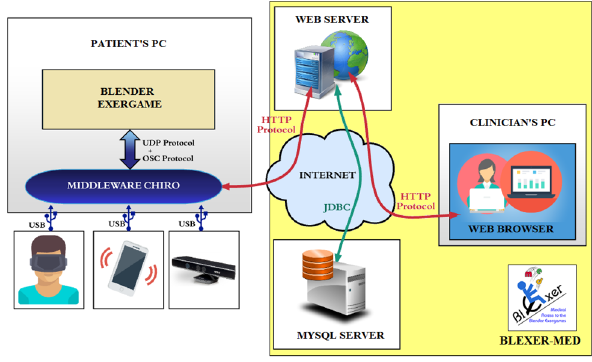
Fig. 1. “Blexer” system environment. Left: patient’s side at home; right: the “Blexer-med” clinical web and